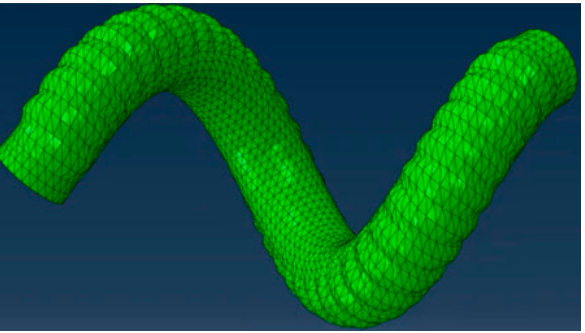
Figure 3. Deformation of the bending module, where ψ is the bending angle and ρ is the radius of curvature.